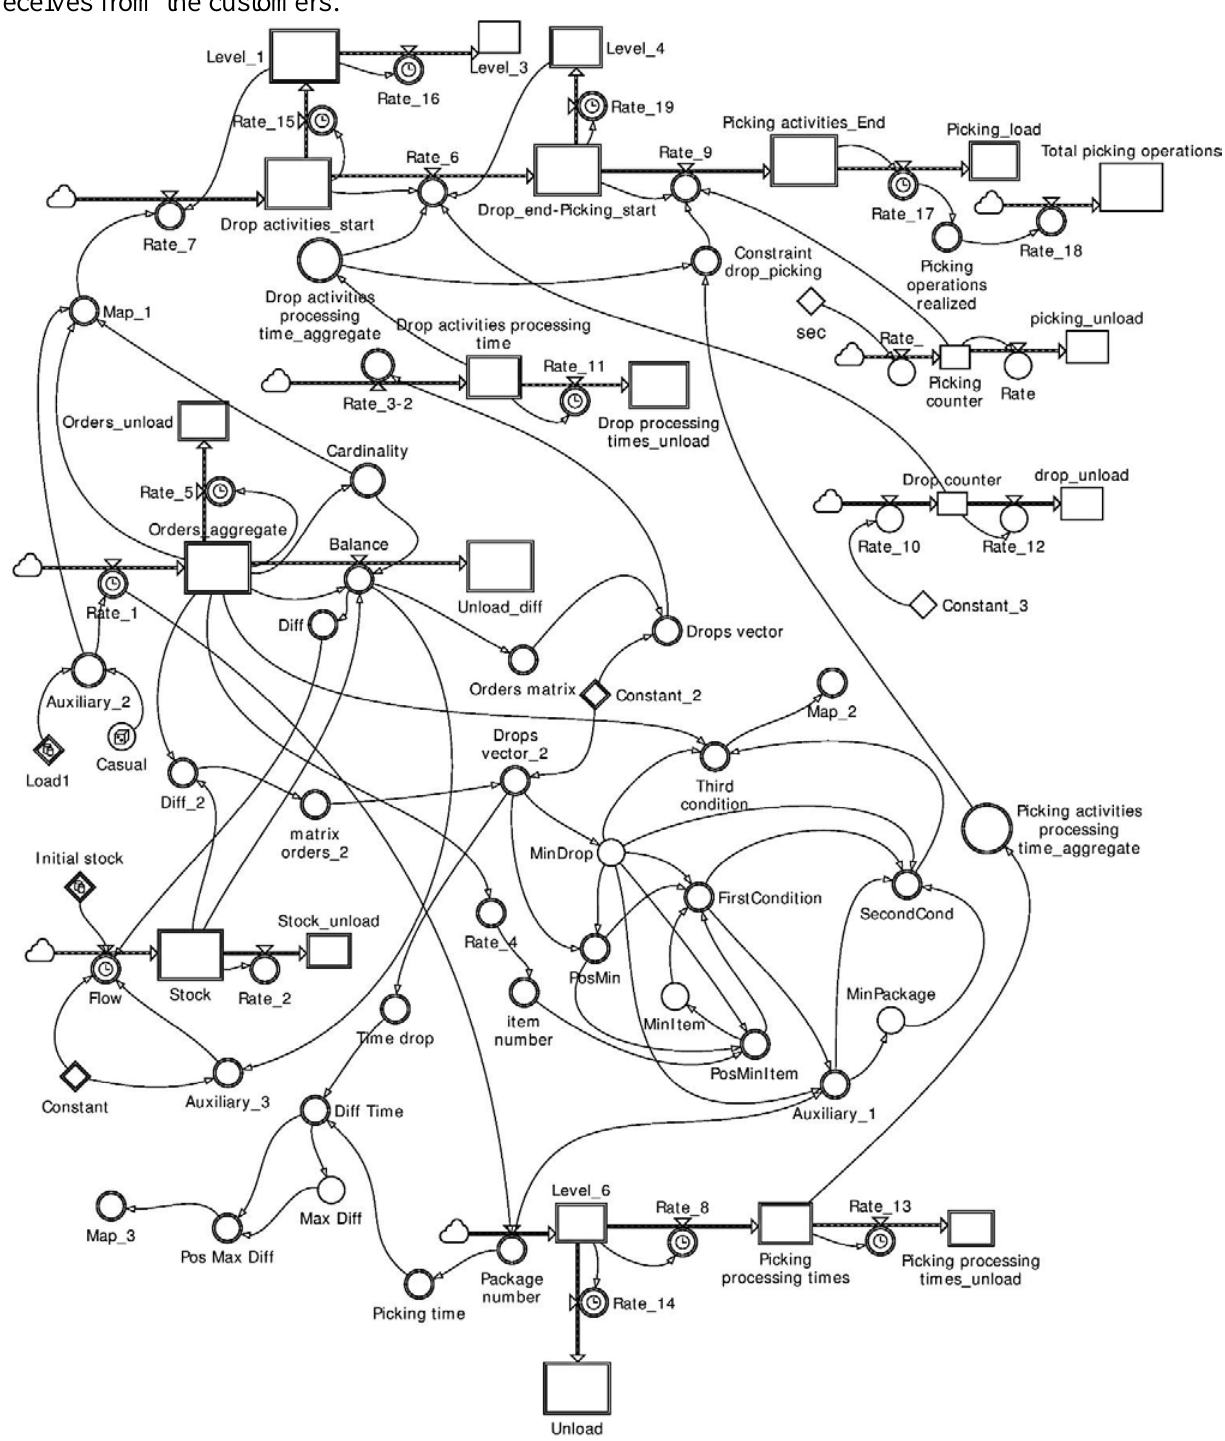
Fig. 4. Model procedure implemented in Powersim